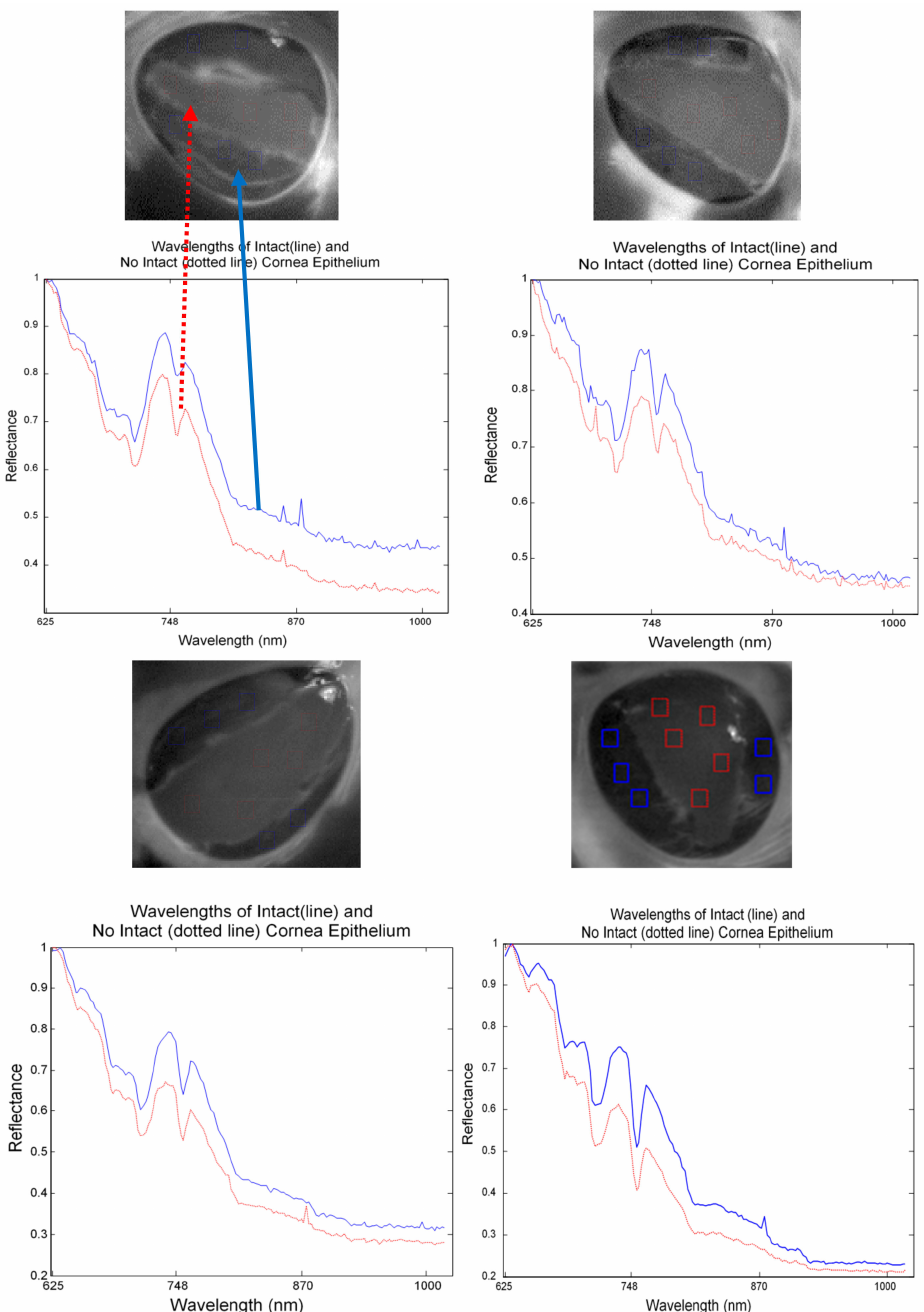
Figure 10. Reflectance signature of injured eye with stain (control